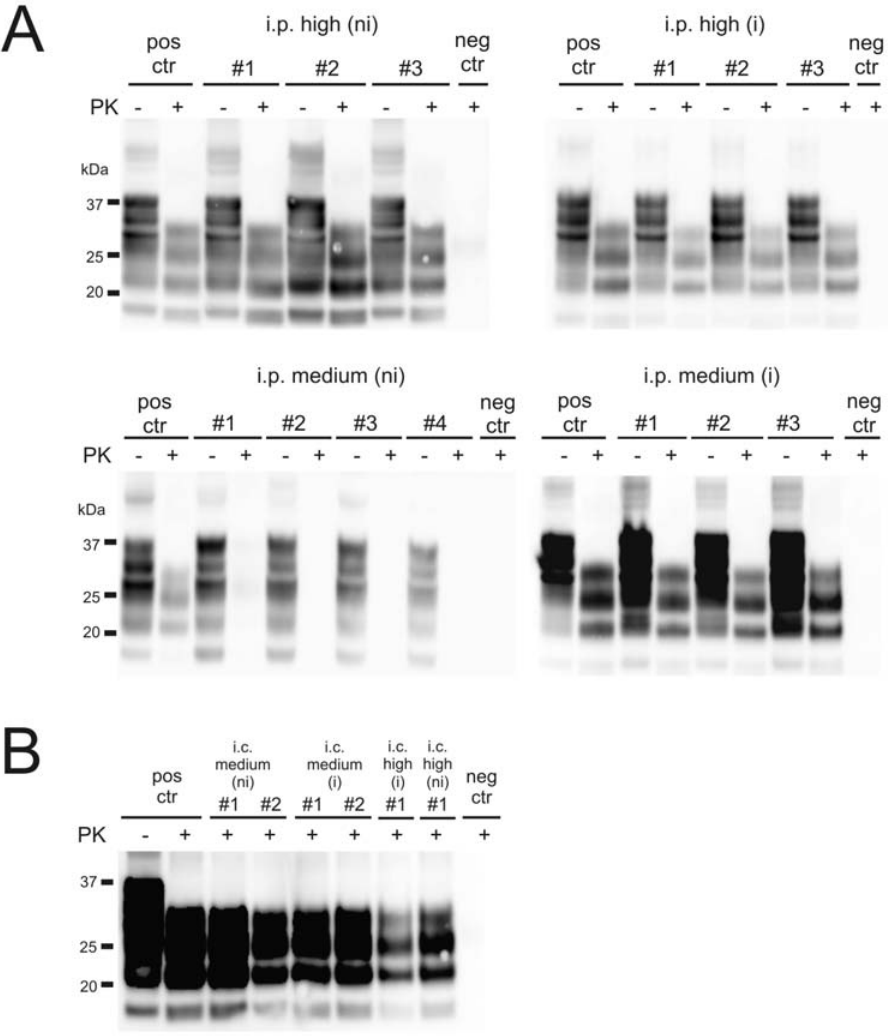
Figure 6. PrP Sc in brains of terminally sick or asymptomatic mice. Immunized (i) and non-immunized mice (ni) inoculated (A) intraperitoneally (i.p.) or (B) intracerebrally (i.c.) with medium or high doses of prions were analyzed by Western blots for the presence of PrP Sc . Brain homogenates were analyzed with ( + ) and without ( 2 ) previous proteinase K (PK) treatment as indicated. Homogenate derived from a terminally scrapie-sick mouse served as positive control (pos ctr), and healthy wild-type mouse tissue as negative control (neg ctr), respectively. Molecular weights are indicated on the left side of the blots. All terminally sick mice showed considerable amounts of PrP Sc in the brain. In contrast, non- immunized mice inoculated i.p. with a medium dose of prions [i.p. medium (ni)] lacked PrP Sc